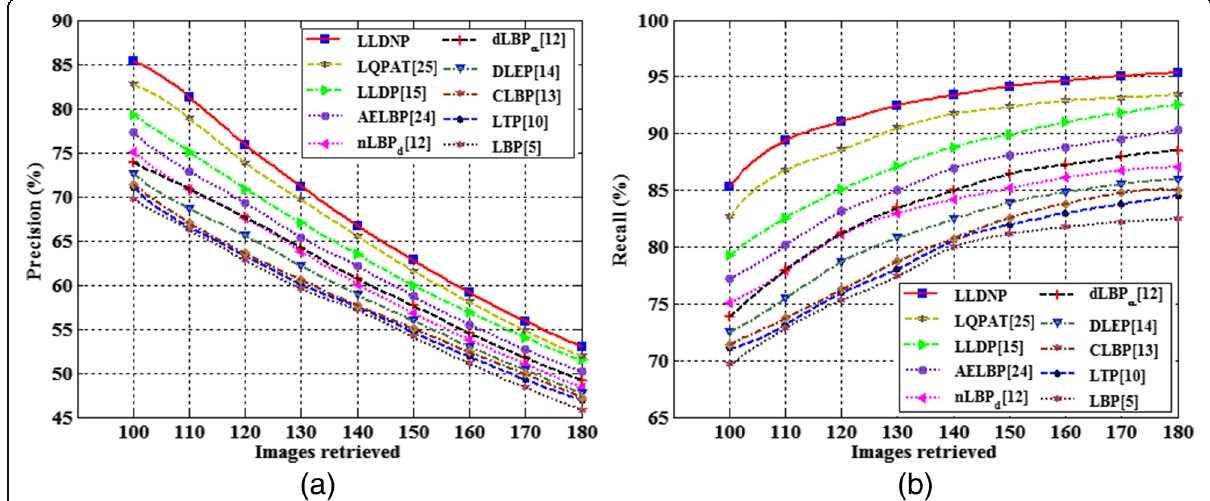
Fig. 19 Comparison of the proposed method with other existing methods in terms of a precision and b recall on Virus database. The performance of existing methods and proposed LLDNP in terms of precision and recall is analyzed. Initially, 100 images are extracted from the database and thereafter the retrieval of images goes up to 180 through a gradual increase at 10 per query. The proposed LLDNP shows improved performance than the other existing methods on Virus database